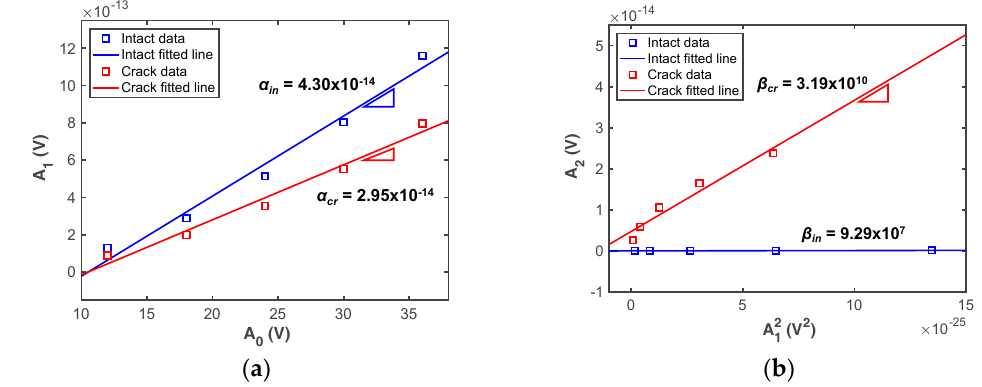
Figure 3. Comparison of representative simulation results between intact and cracked conditions at 10 ◦ C: ( a ) α , ( b ) β . Subscripts in and cr denote intact and cracked conditions, respectively.